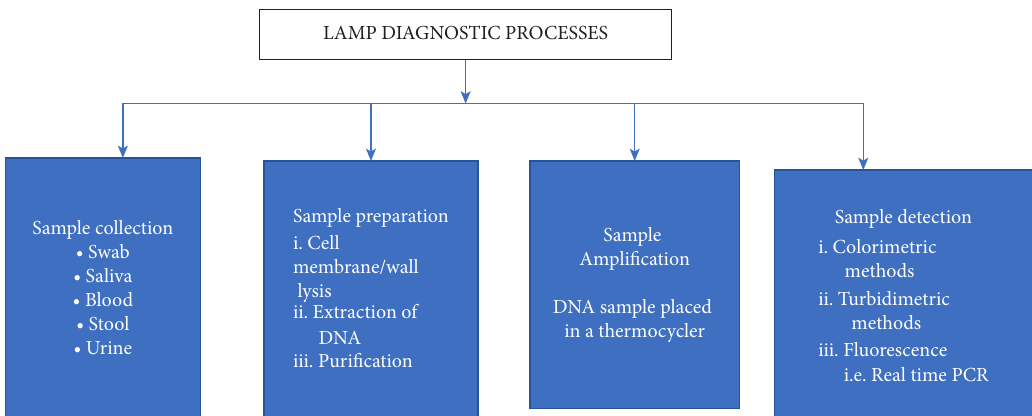
Figure 2: Diagrammatic illustration of the LAMP assay workflow. Sample collection, preparation, amplification, and detection are the four distinct steps. Urine, stool, blood, saliva, and nose swabs are among the samples used. Lysing the cell, extracting the nucleic acids of interest, purification, elution, amplification, and detection are all important stages. However, because the LAMP assay uses Bst DNA polymerase, which is unaffected by inhibitors, the sample extraction step is skipped. Nucleic acids of interest are amplified in this experiment using a water bath, heater block, or thermocycler set to a single temperature. Colorimetric, turbidimetric, and fluorescence techniques are used for detection [40].